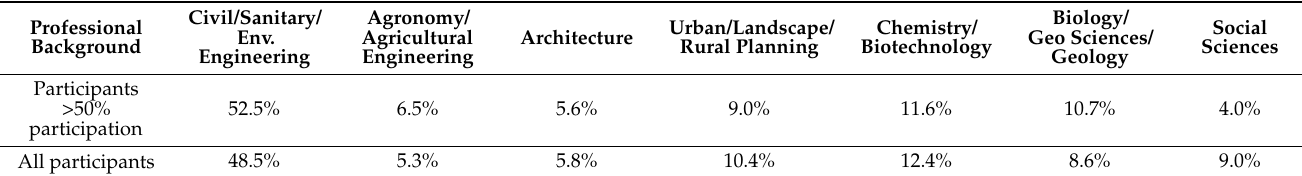
Table 2. Professional background of participants in the Circular City workshops.